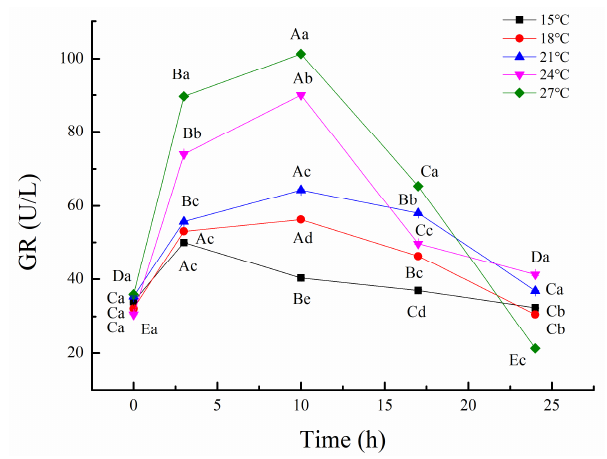
Figure 2. E ff ect of temperature on glutathione reductase (GR) of tiger grouper during simulated Figure 2. Effect of temperature on glutathione reductase (GR) of tiger grouper during transport. Among di ff erent temperature transport groups, di ff erent small and capital letters indicate simulated transport. Among different temperature transport groups, different small and the results of Duncan’s test at di ff erent transport time. The same letters mean no significant di ff erence capital letters indicate the results of Duncan’s test at different transport time. The same letters ( p > 0.05), while di ff erent letters mean significant di ff erence ( p < 0.05). Di ff erent letters without mean no significant difference ( p > 0.05), while different letters mean significant difference ( p < * = p -value < 0.05, di ff erent letters with ** = p -value < 0.05). Different letters without * = p- value < 0.05, different letters with ** = p- value < 0.01.